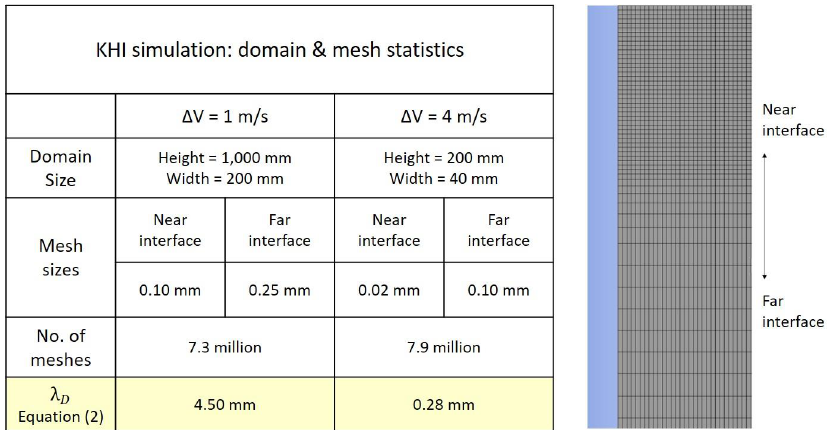
Energies 2022 , 15 , x FOR PEER REVIEW Figure 7. Computational domain and mesh information of 2D KHI simulations. Figure 7. Computational domain and mesh information of 2D KHI simulations.